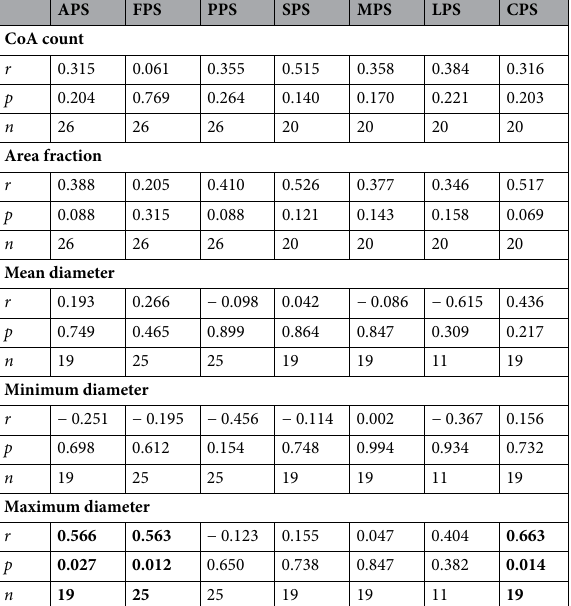
Table 4. Spearman’s Rho correlation of patients’ BMI with tested CoA parameters. Significant differences are indicated in bold. The listed p values are after adjustment for Type 1 error with FDR. APS alveus pial